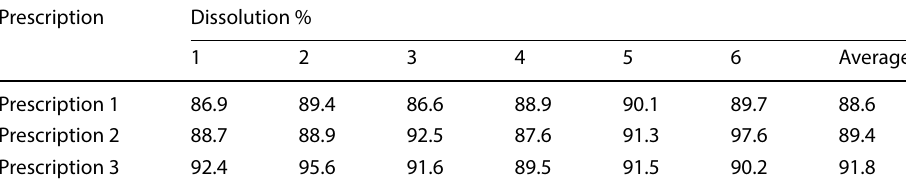
Table 4 Dissolution test results of prescription samples